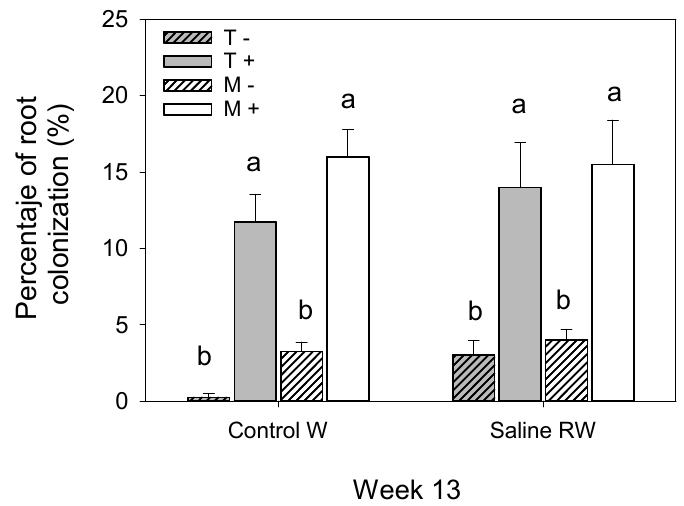
Figure 1. Percentage of root colonization in tomato plants irrigated with control water (Control W) and saline reclaimed wastewater (Saline RW) growing in traditional soil (T) or mixed substrate (M) without ( − ) and with AMF (+) inoculation. Different lowercase letters indicate significant differences between treatments according to Duncan test at p ≤ 0.05.